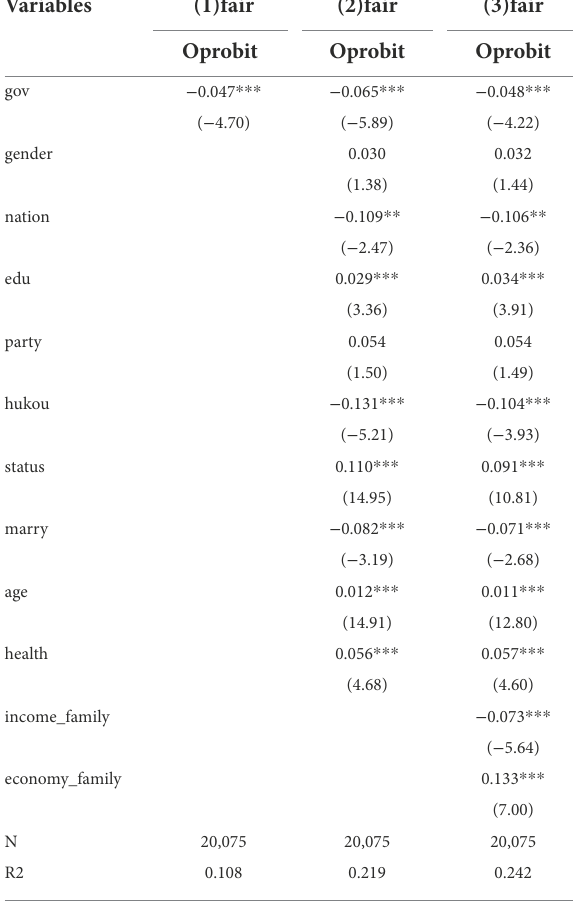
TABLE 2 Basic regression results. TABLE 3 Regression results of marginal effects of the effects of various variables on Perceptions of social